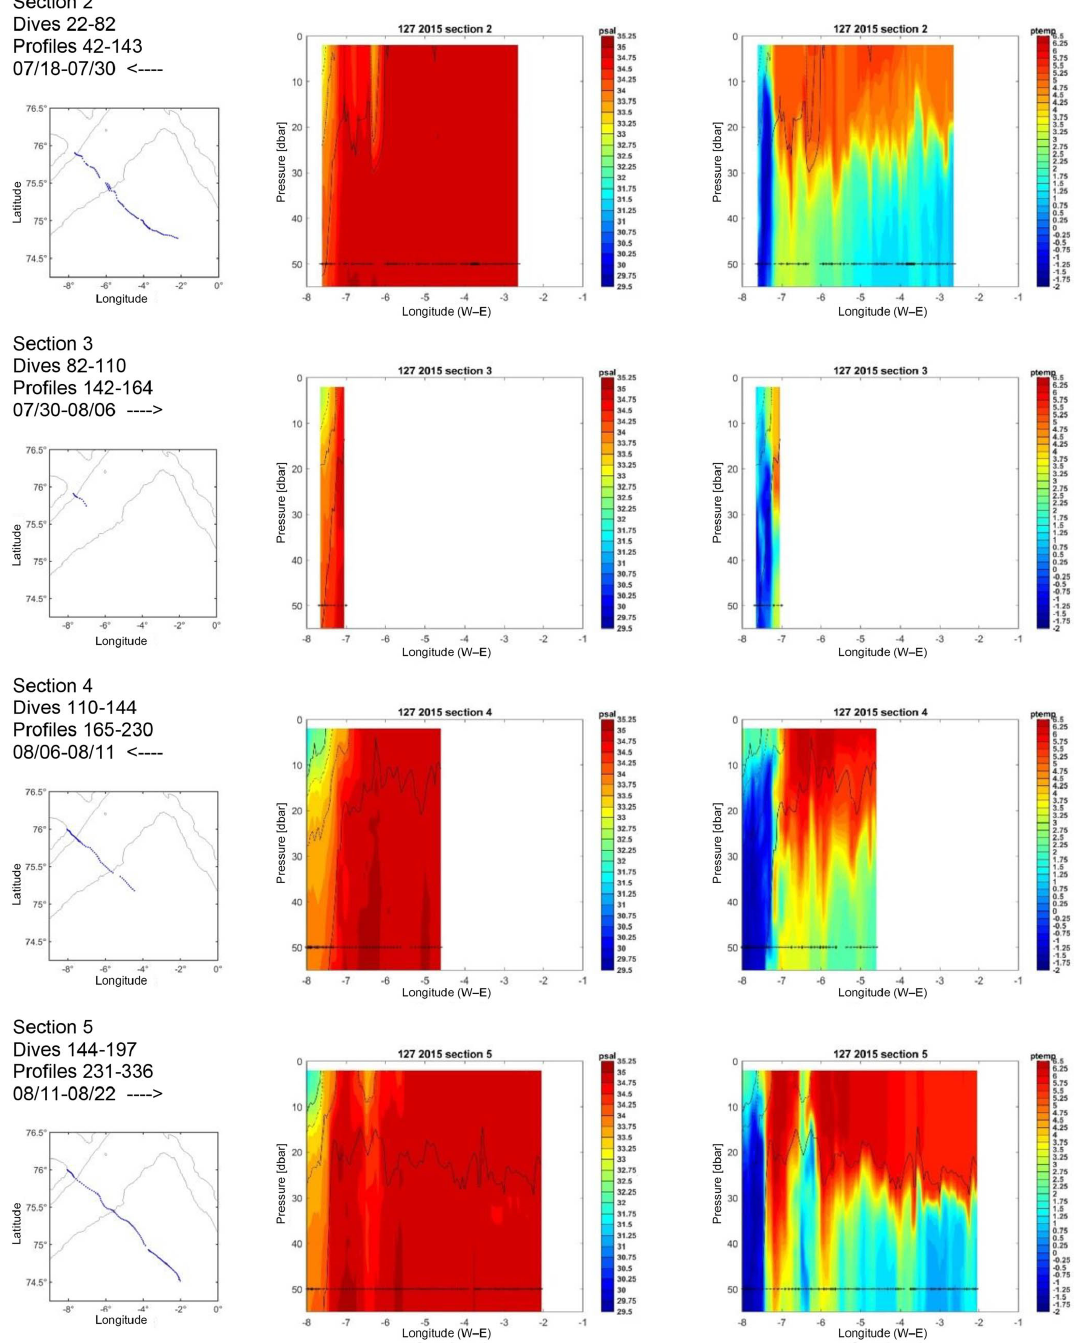
“quasi-synoptic”. Thus, the combination of low time resolu- tion and high spatial resolution provided by glider measure- ments must be considered, when deriving quantitative con- clusions from the observed distributions.